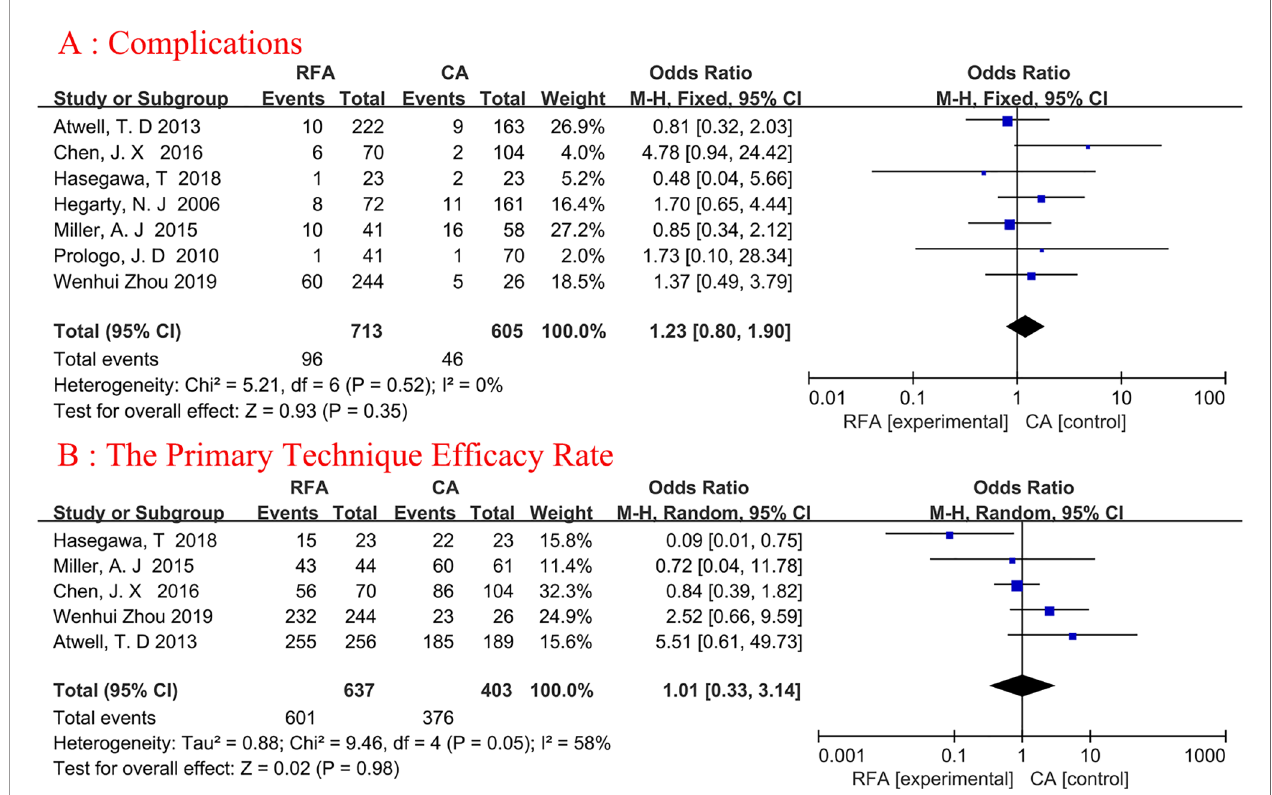
FIGURE 3 | Forest plot and meta-analysis of complications (A) and the primary technique ef fi cacy rate (B)